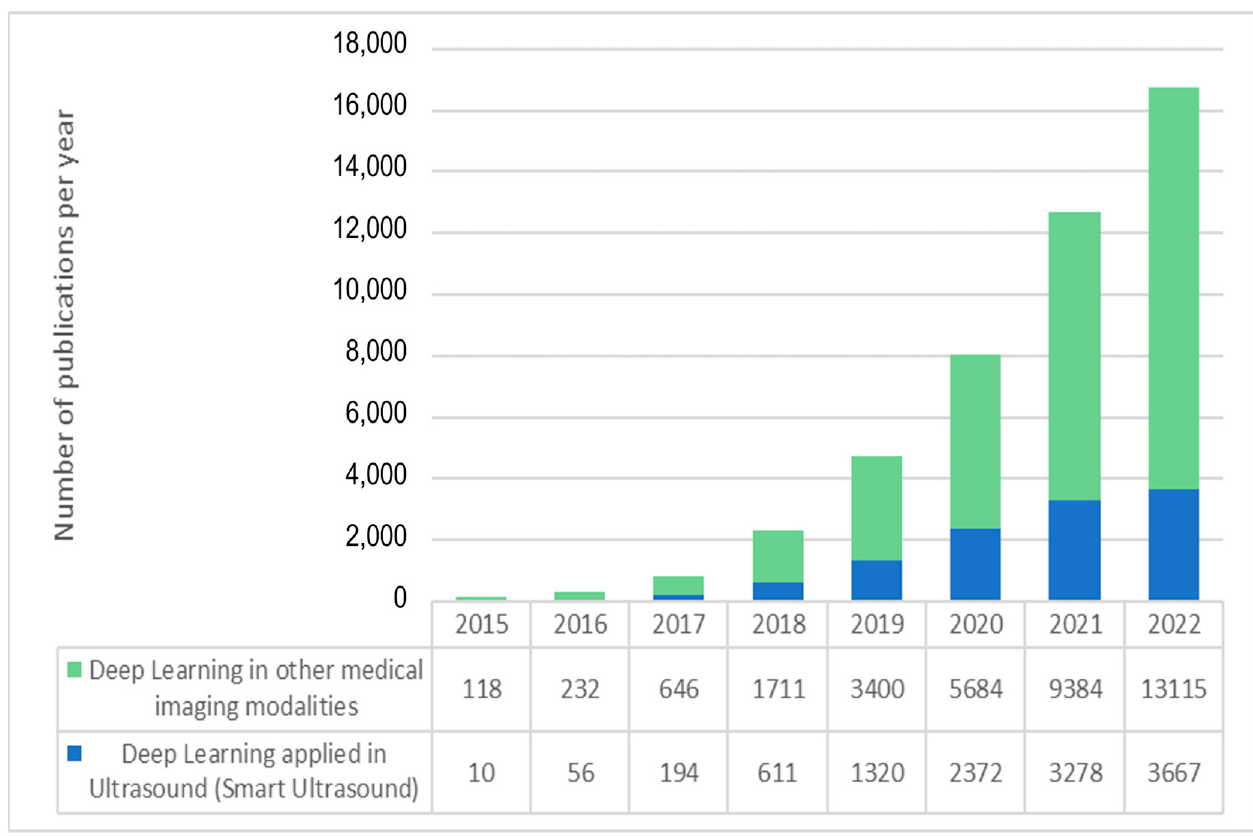
Figure 1. Exponential growth in the number of articles indexed in PubMed with “deep learning” and “ultrasound” (blue) and “deep learning” applied to other data and medical image modalities.